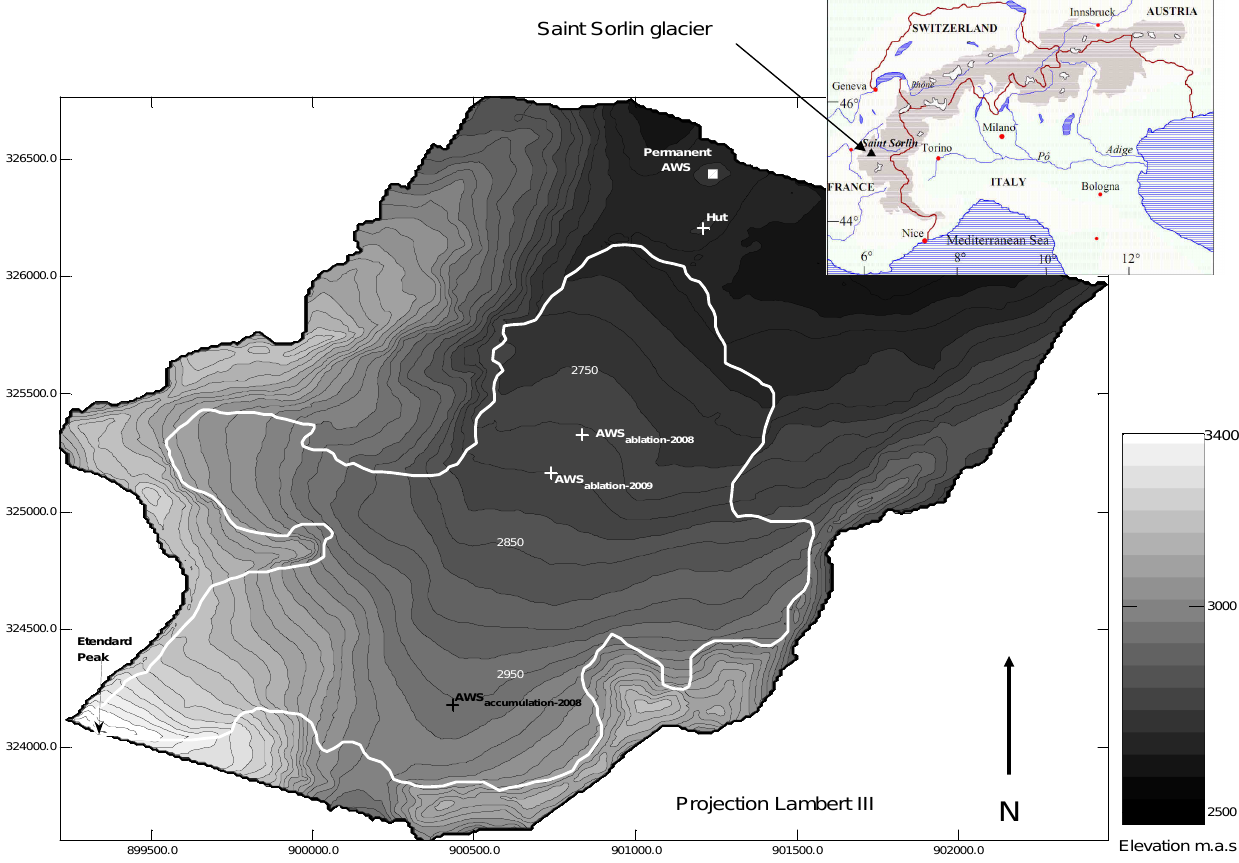
Fig. 1. Map of Saint Sorlin Glacier. Location of the AWS used for validation during summer 2008 and summer 2009 are indicated on the glacier. The cameras take photographs from the hut. Etendard peak is also